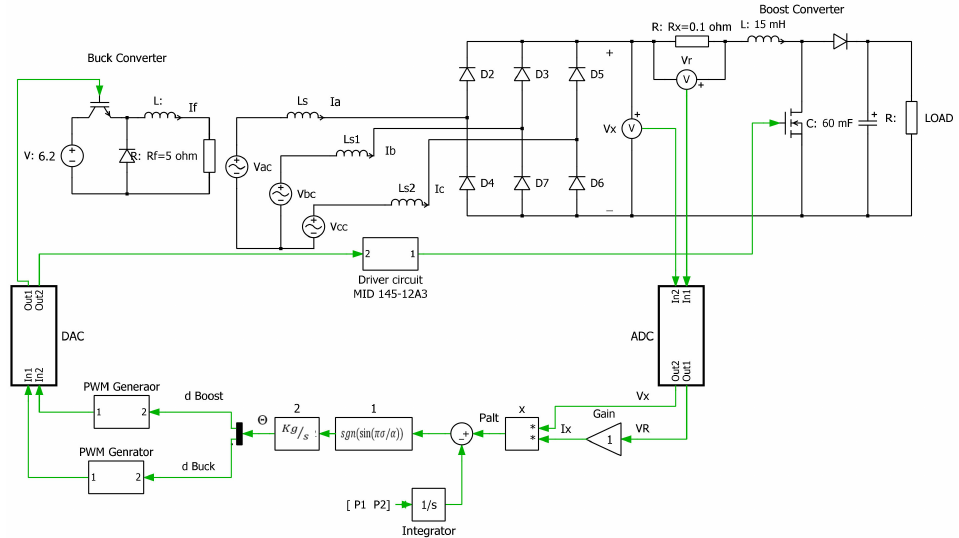
Figure 30. Experimental setup for the real-time circuit “Reprinted and adapted with permission from [28]”.